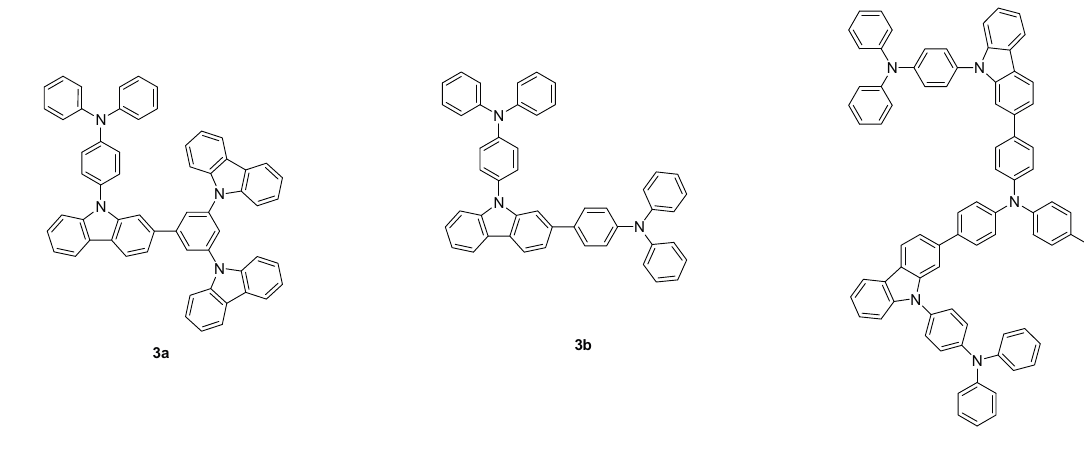
Figure 1. Structures of the designed HTMs 3